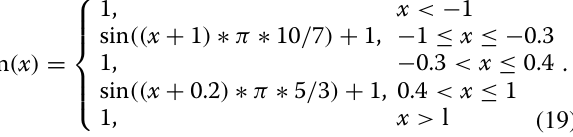
First boundary x from 1.5 to 0.5 − −